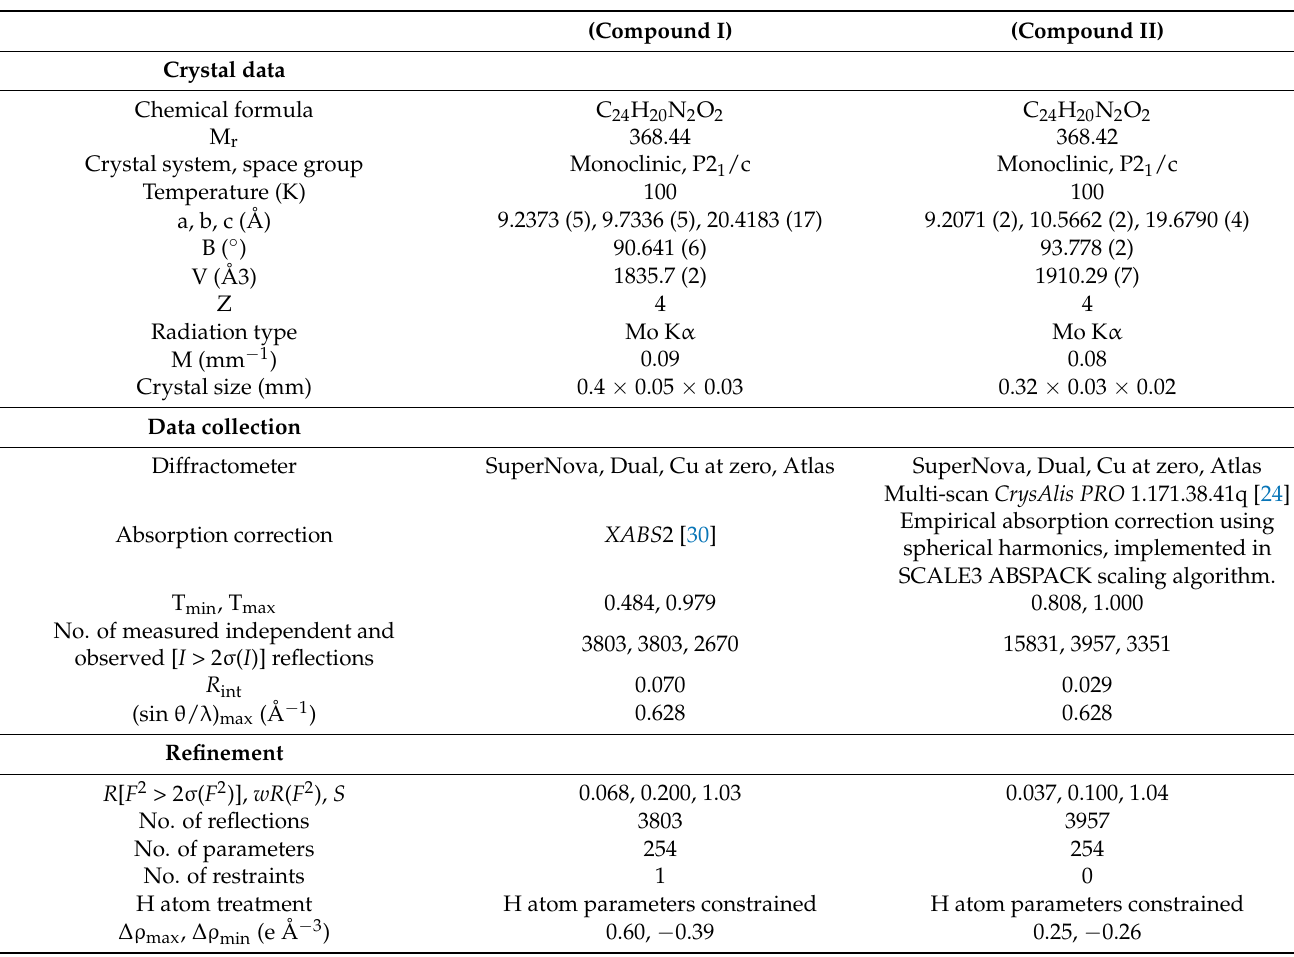
Table 4. Experimental